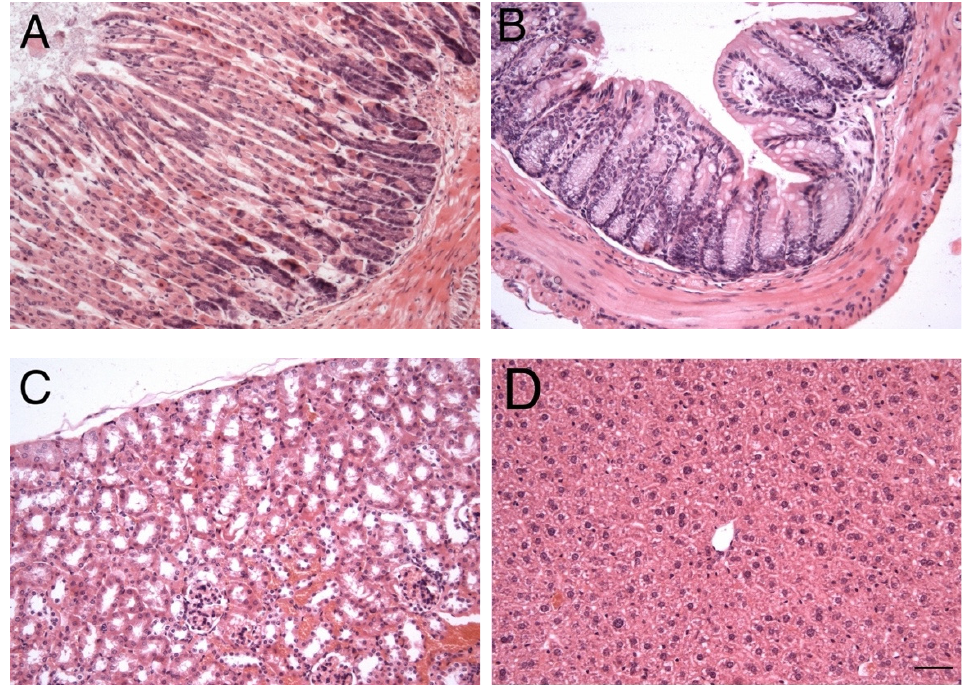
Figure 7. Effects of GPs on the stomach ( A ), small intestine ( B ), kidney ( C ) and liver ( D ) of C57Bl/6 mice after 21 days of oral exposure. The nanomaterial did not change the tissue morphology of listed organs; their microstructure was identical to the control group. The scale bar = 20 μ m; staining haematoxylin-eosin.